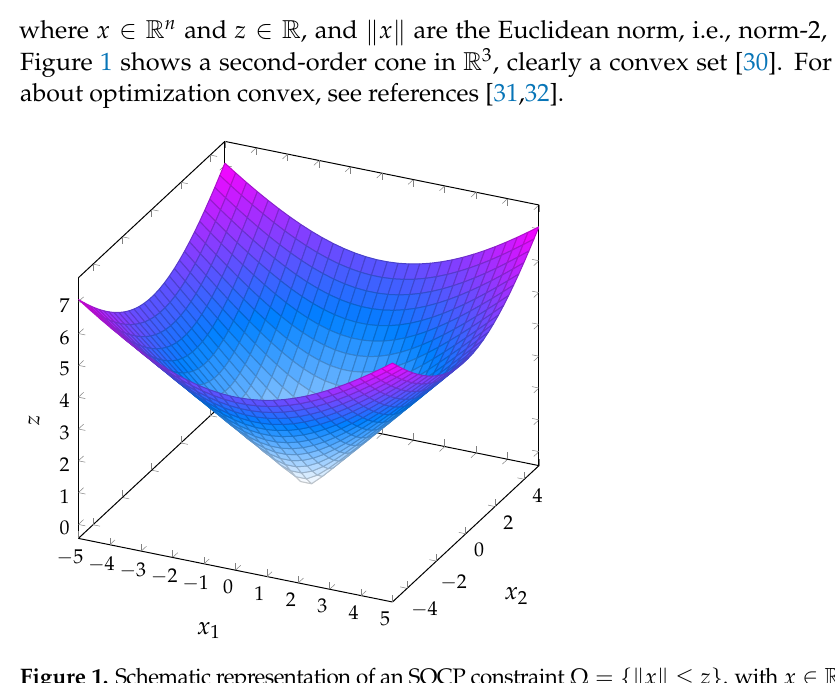
Figure 1. Schematic representation of an SOCP constraint Ω = {(cid:107) x (cid:107) ≤ z } . with x ∈ R 2 and z ∈ R